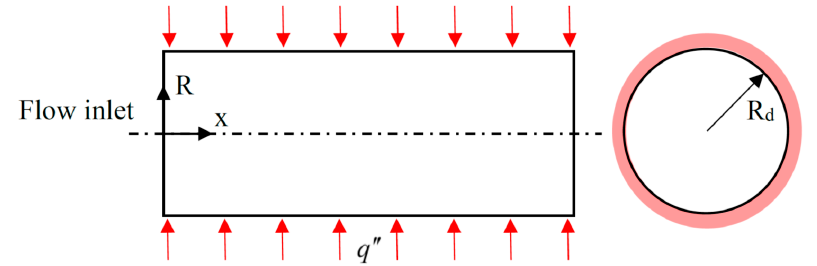
Figure 2. Physical model used for the model validation.